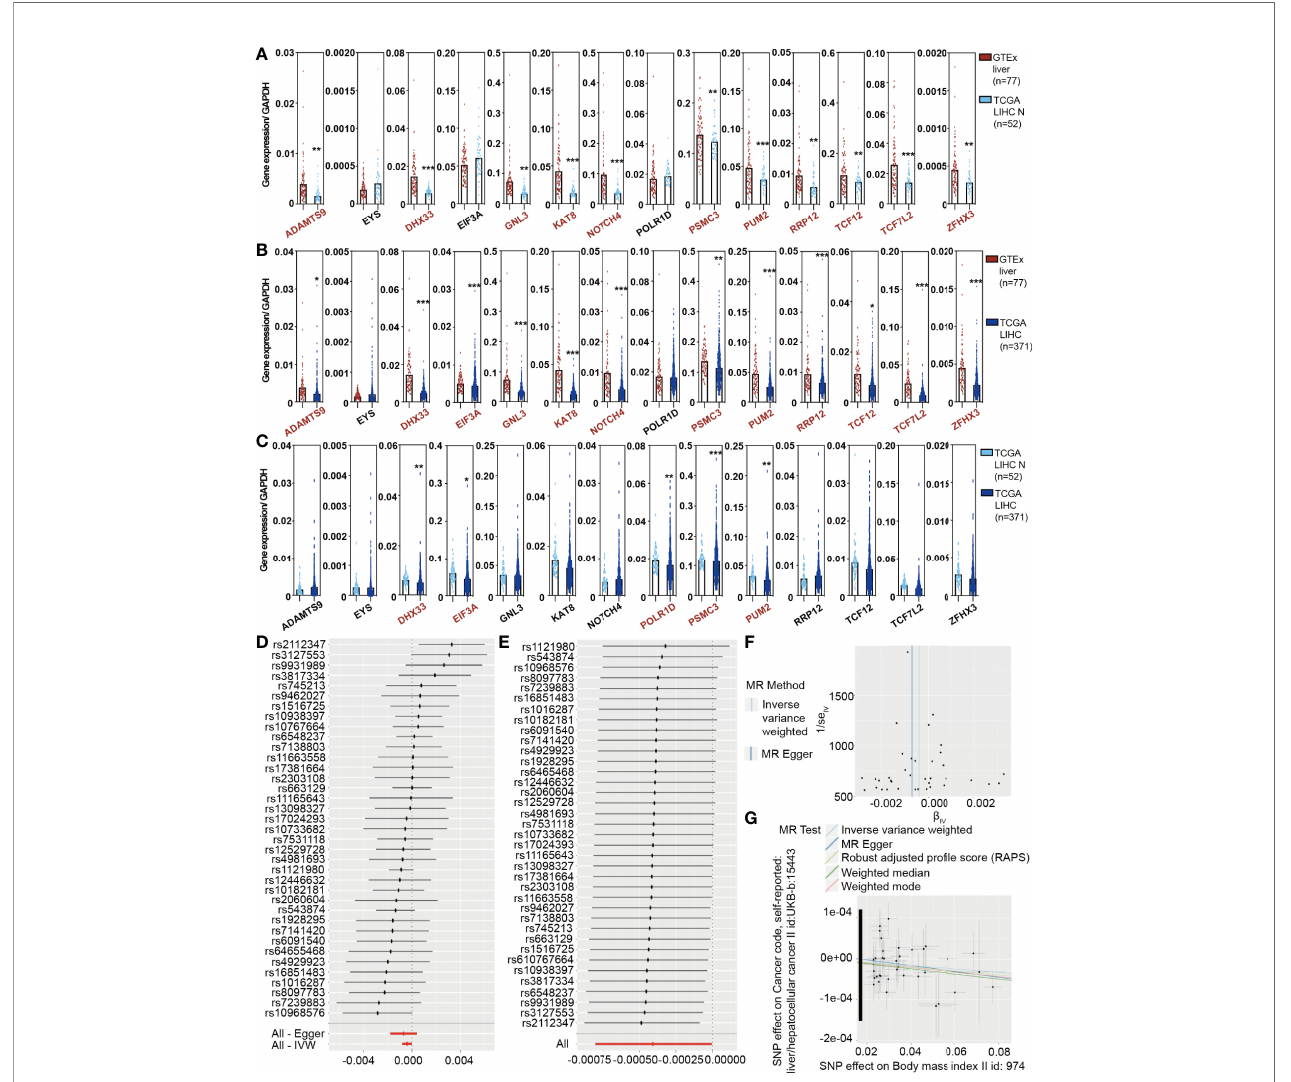
FIGURE 1 | The Cancer Genome Atlas (TCGA) analysis and the MR results reveal a causal association between obesity and hepatocellular carcinoma (HCC) in females. (A) Expression of 14 obesity-related genes/GAPDH in GTEx liver and TCGA liver hepatocellular carcinoma (LIHC) normal samples. (B) Expression of 14 obesity-related genes/ GAPDH in GTEx liver and TCGA LIHC tumor samples. (C) Expression of 14 obesity-related genes/GAPDH in TCGA LIHC normal and tumor samples. (D) A strati fi ed analysis demonstrated that obesity was not related to the incidence of HCC in the total population. (E) A strati fi ed analysis further revealed that obesity was negatively correlated with the incidence of HCC in females. (F, G) The Mendelian randomization Egger test showed a signi fi cantly negative correlation between obesity and HCC